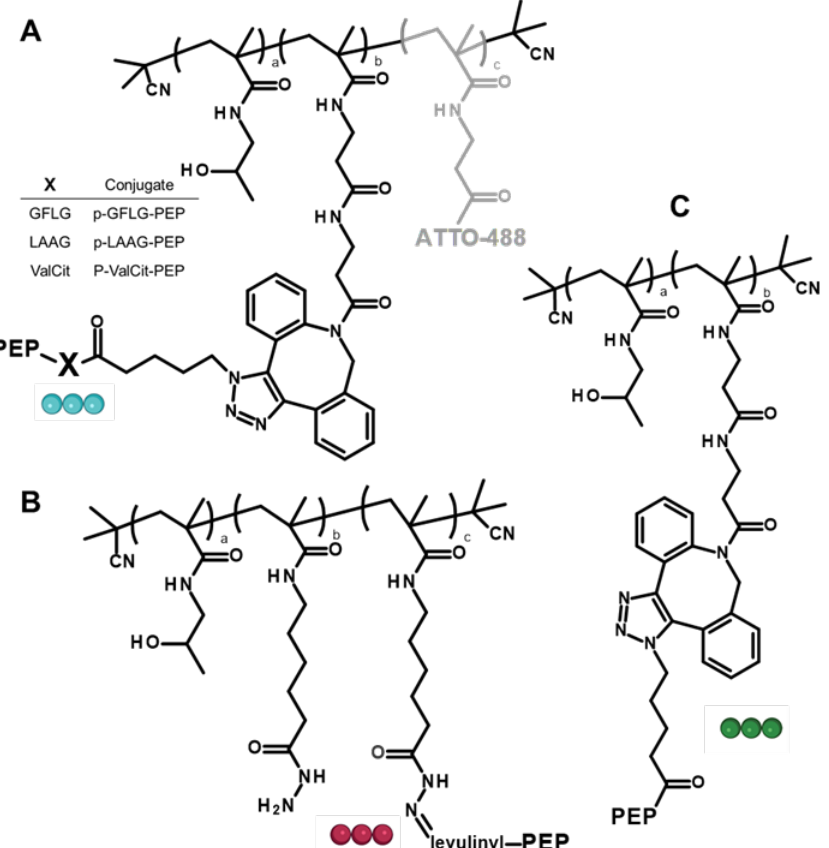
Figure 3. Structures of the polymer-AMP constructs: ( A ) enzymatically degradable, ( B ) hydrolytically cleavable, and ( C ) with a non-cleavable spacer between the polymer backbone and the AMP. Color of the ball linker is related to the mechanism shown in Figure 2.